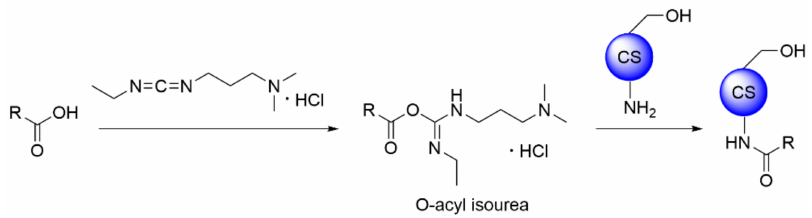
Scheme 1. Carbodiimide-mediated amide bond